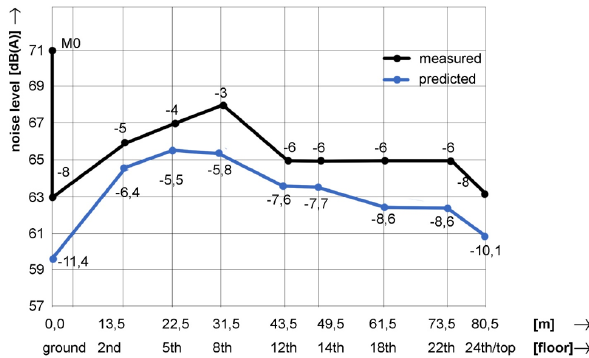
Figure 12: Predicted and measured road traflc noise (L A 10 ) along the façade of “Apollon”. M0: reference point